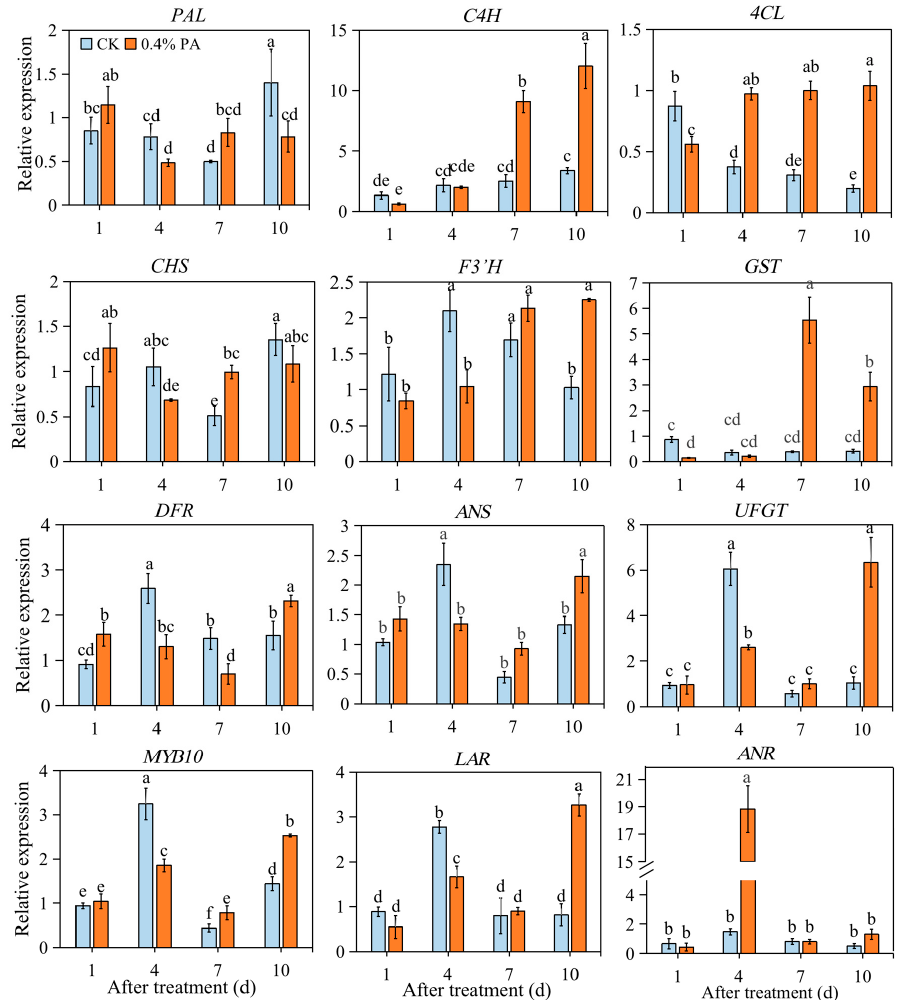
Figure 4. Relative expression of anthocyanins- and PA-related genes under 0.4% PA treatment. PAL : phenylalanine ammonia lyase; C4H : cinnamate 4-hydroxylase; 4CL : 4-coumarate:coenzyme A ligase; CHS : chalcone synthase; F3 ′ H : flavonoid 3 ′ -hydroxylase; GST : glutathione transferase; DFR : dihydroflavono-4-reductase; ANS : anthocyanidin synthase; UFGT : UDP-glucose flavonoid-3-O-glycosyltransferase; LAR : leucoanthocyanidindin reductase; ANR : anthocyanidin reductase. The data are presented as mean values ± standard deviation. Mean values were obtained from three independent biological replicates. The lowercase letters indicate significant difference based on LSD multiple test at p ≤ 0.05 level.